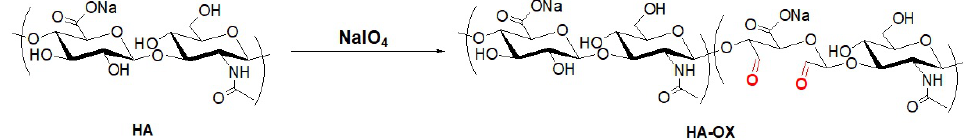
Figure 2. Oxidation of